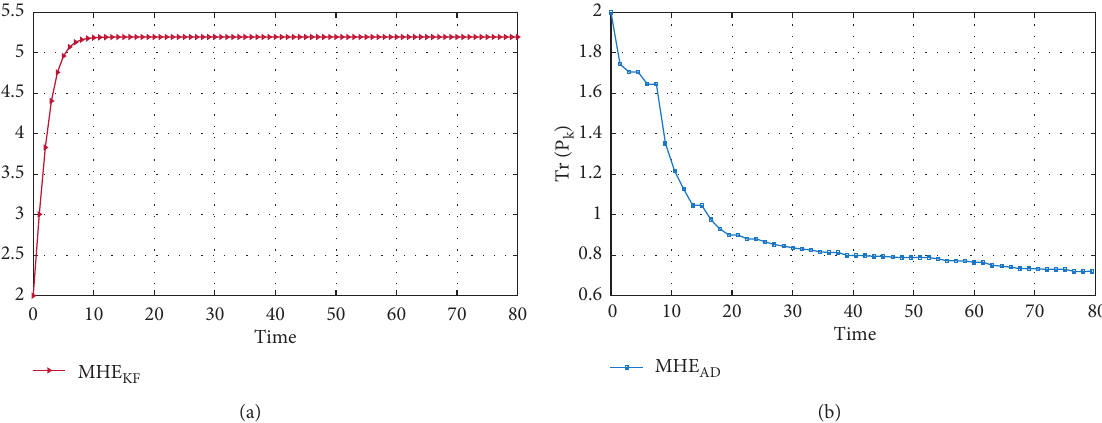
Figure 3: Evolution of trace ( P